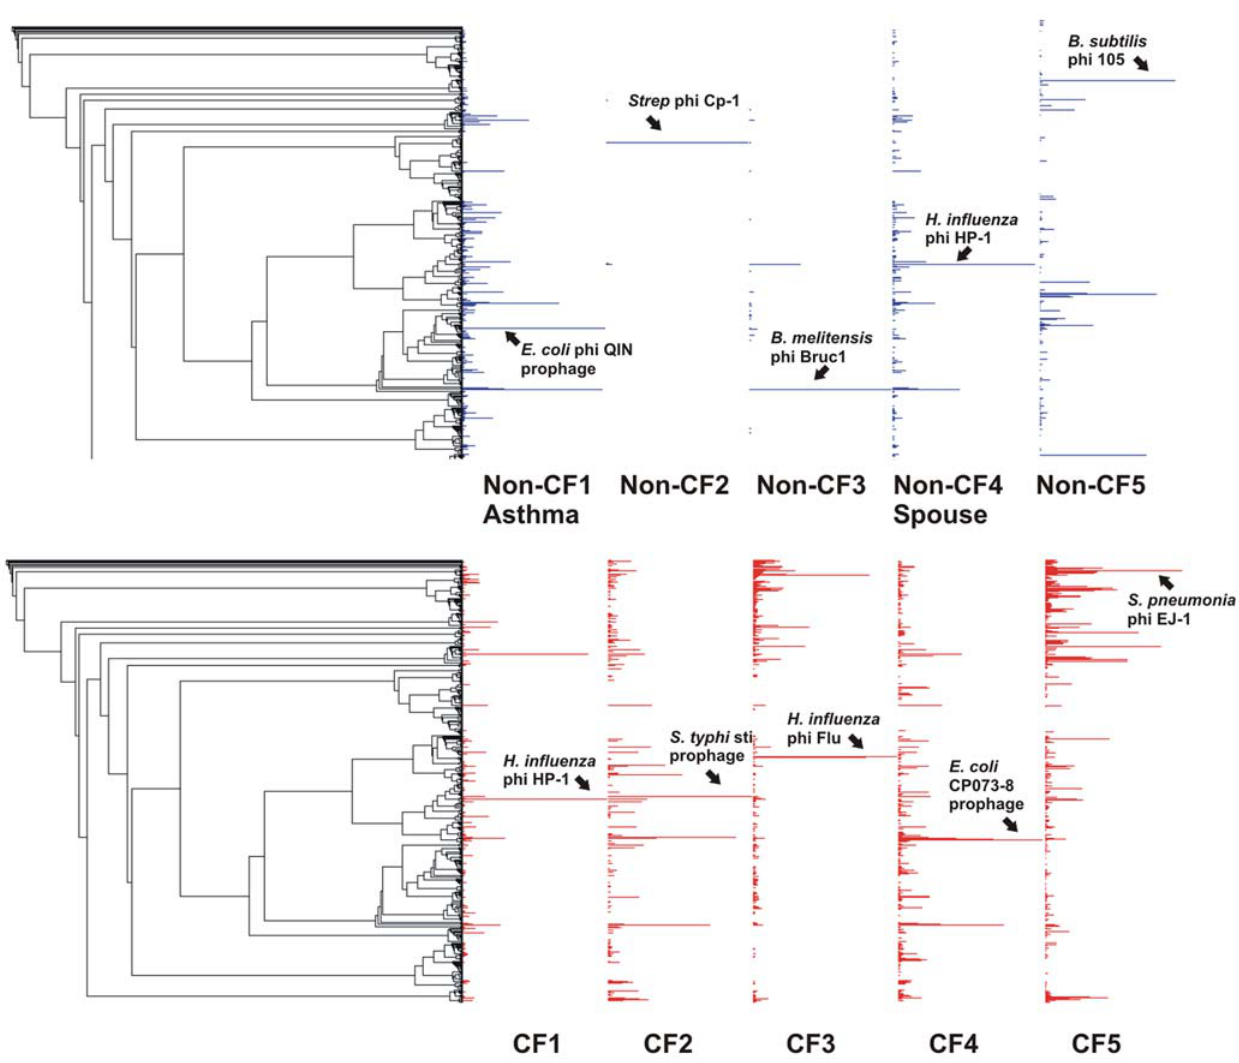
Figure 1. Mapping of best tBLASTx hits to the phage proteomic tree by percentage for Non-CF (A) and CF (B) viromes. The phage genome with the highest percentage of hits (normalized to the length of the genome) is labeled for each virome.